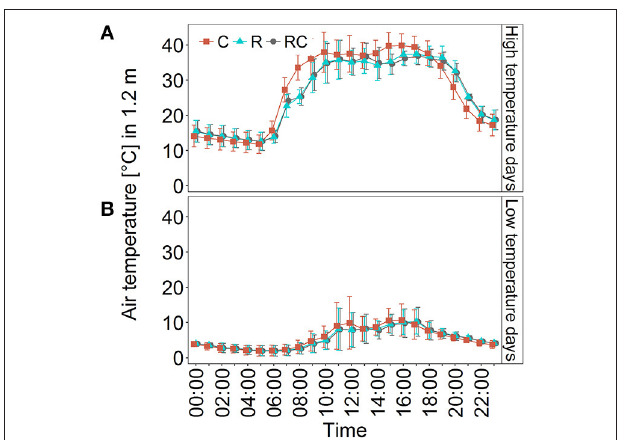
FIGURE 4 | Air temperature ( ◦ C) as measured in 1.2m height using iButton temperature loggers under the rainout-shelter (R), the rainout-shelter control treatment (RC), and the ambient control plots (C). Data points represent hourly temperature measurements (means ± standard deviation) of two plots and 3 days during (A) a high temperature phase (June 18–20, 2017) and (B) a low temperature phase (April 26–28, 2017).